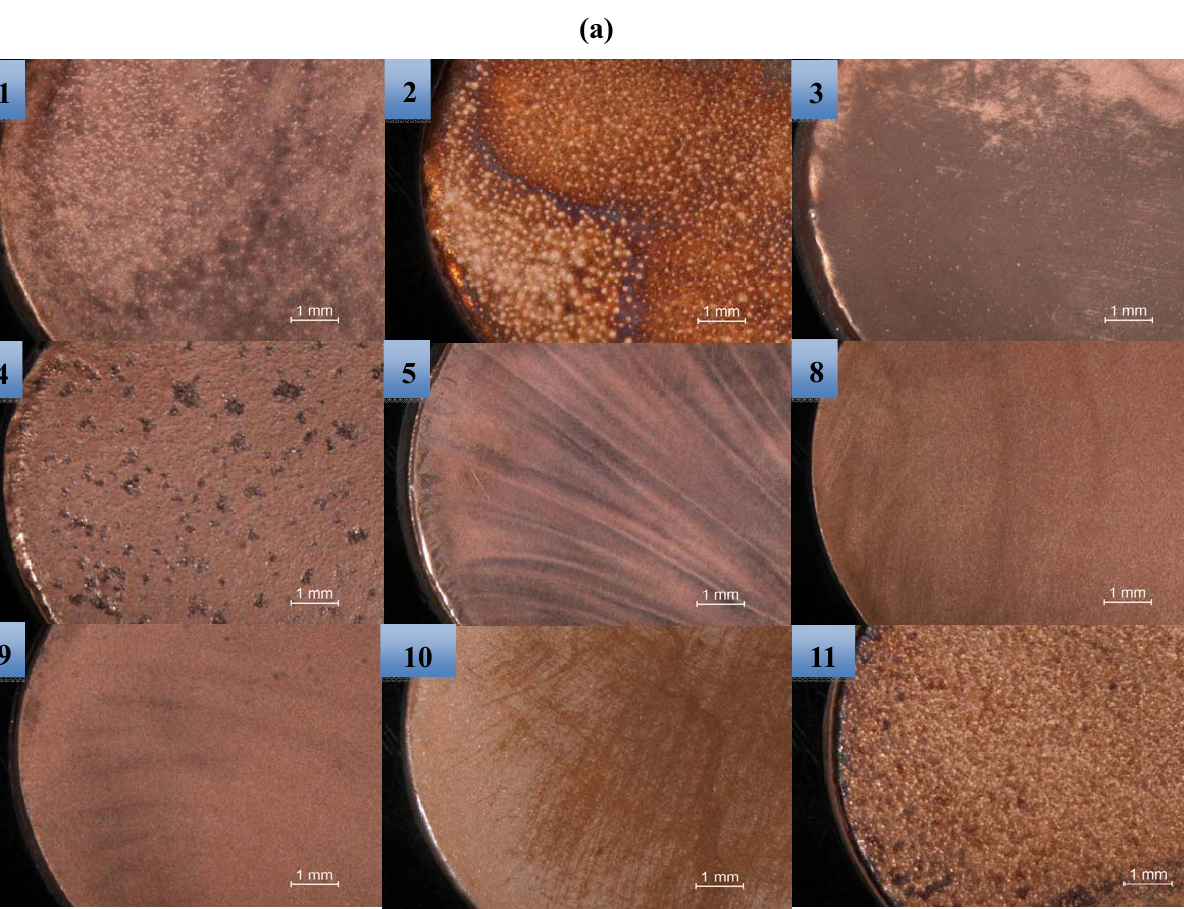
Figure 6. ( a ) Optical images of the anodically polarized pure copper in various NaCl solutions (different concentrations and pH values) on a macro scale; ( b ) related SEM images and ( c ) SEM images of the corroded copper samples using a microcapillary cell. The numbers indicate the designed experiments mentioned in Table 1. Scan